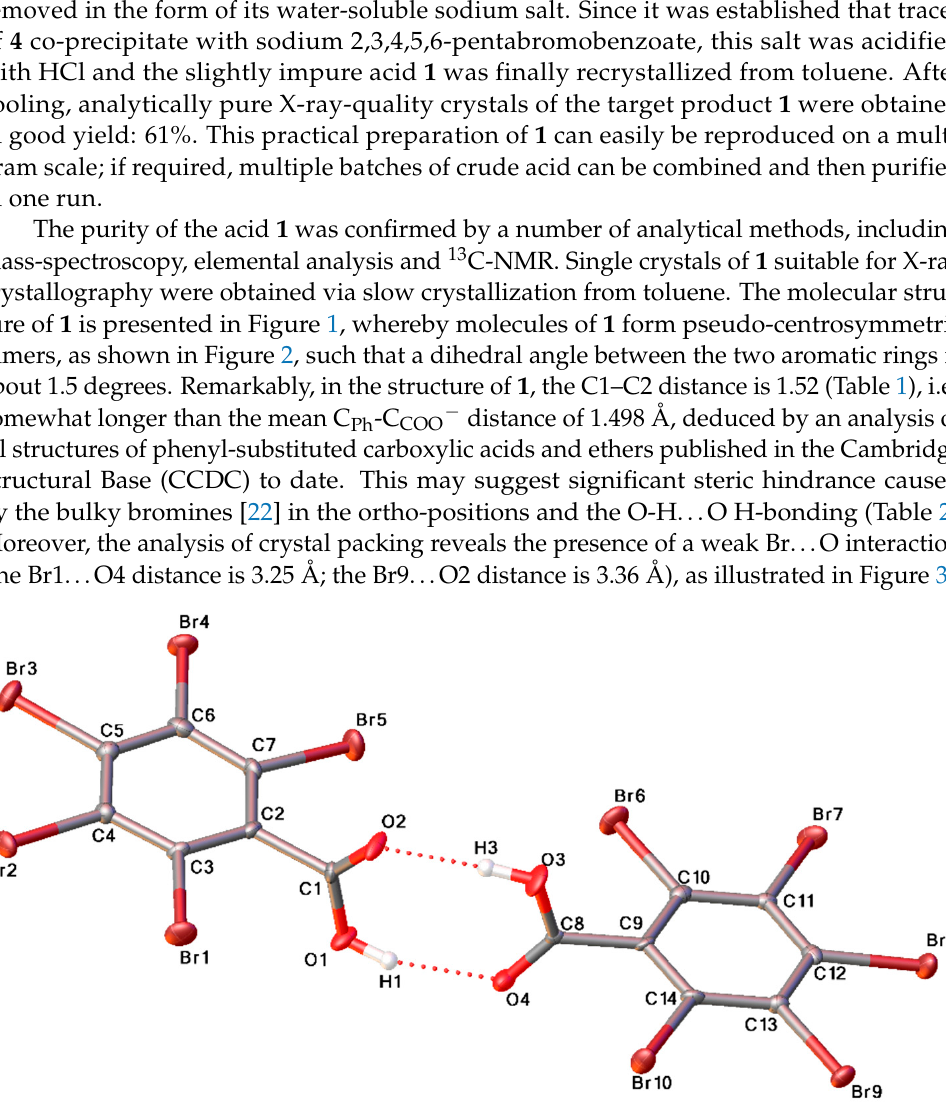
Figure 1. General view of the asymmetric unit of 1 with the thermal ellipsoids presented at 50% probability. Hydrogen O–H...O bonds are illustrated with dotted lines. Table 1. List of bond lengths for 1